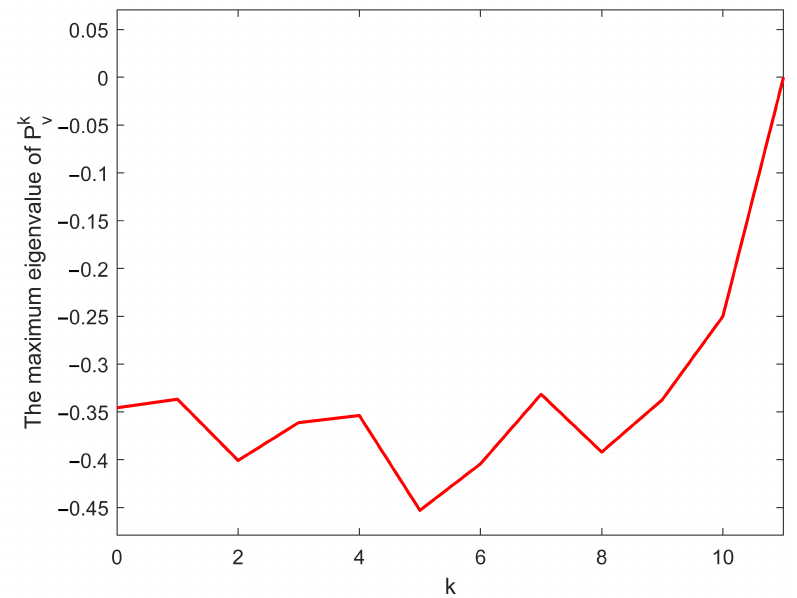
Figure 3. The maximum eigenvalue of P k v .